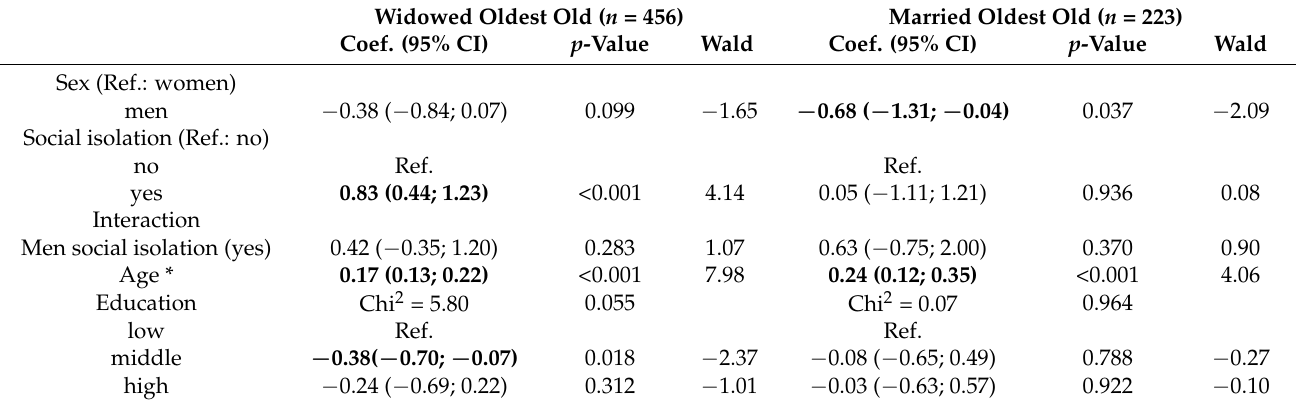
Table 3. Predictors of depression symptoms * in the course of time in the two subsamples “widowed oldest old” and “married oldest old” 1